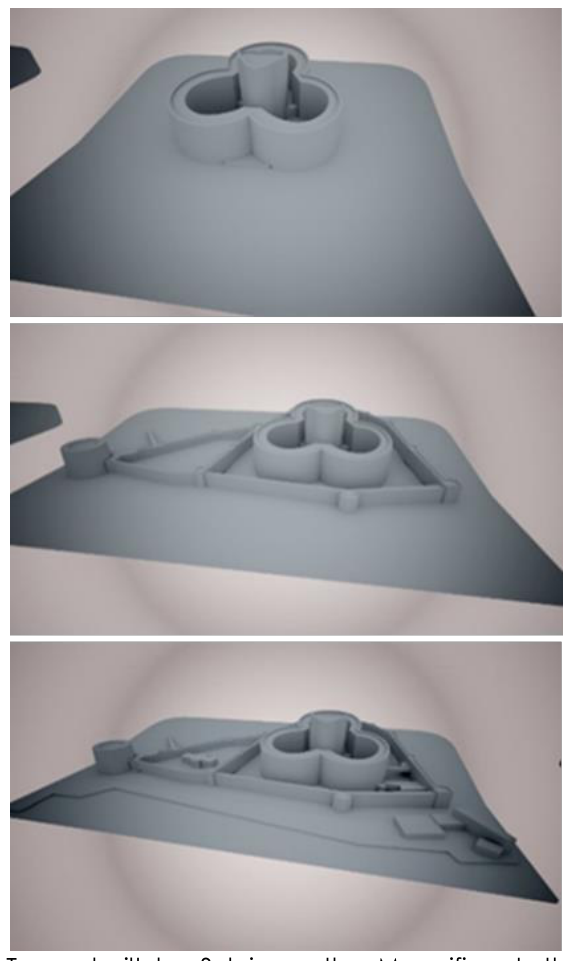
Figure 08: Era of the Conqueror (Inner Tower) - Era of Suleiman the Magnificent (Yellow Tower, Late Period Courtyard) - Era of Abdülhamit (Military Factory, Shrine), K. Duyar.